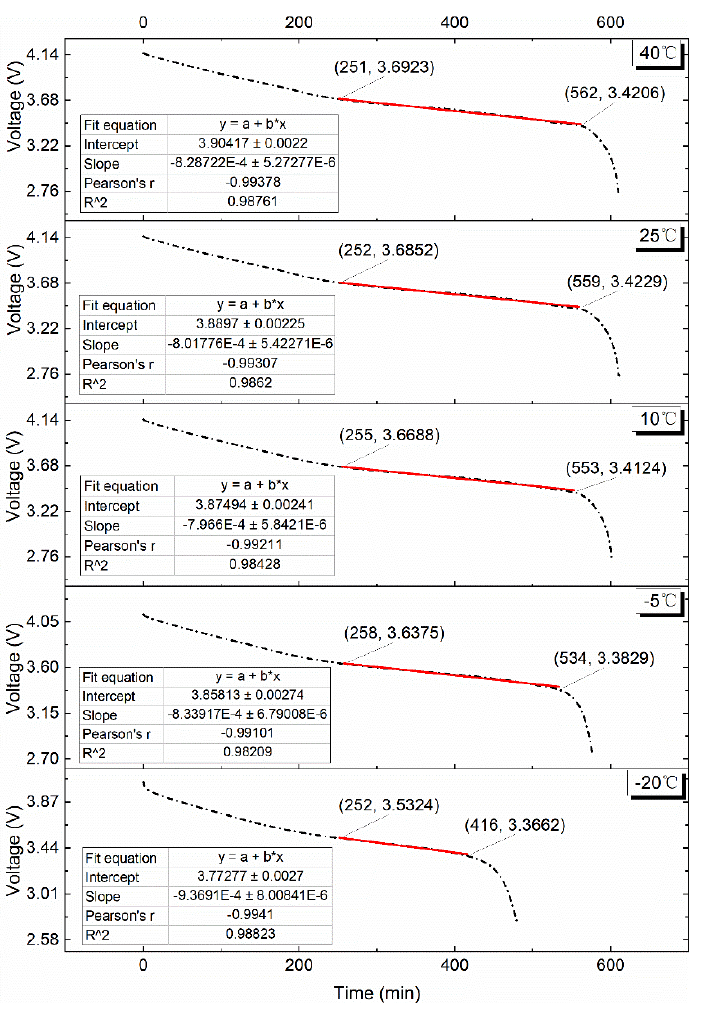
Figure 7. Influence rule of different ambient temperatures on voltage plateau period during 0.1C discharge.